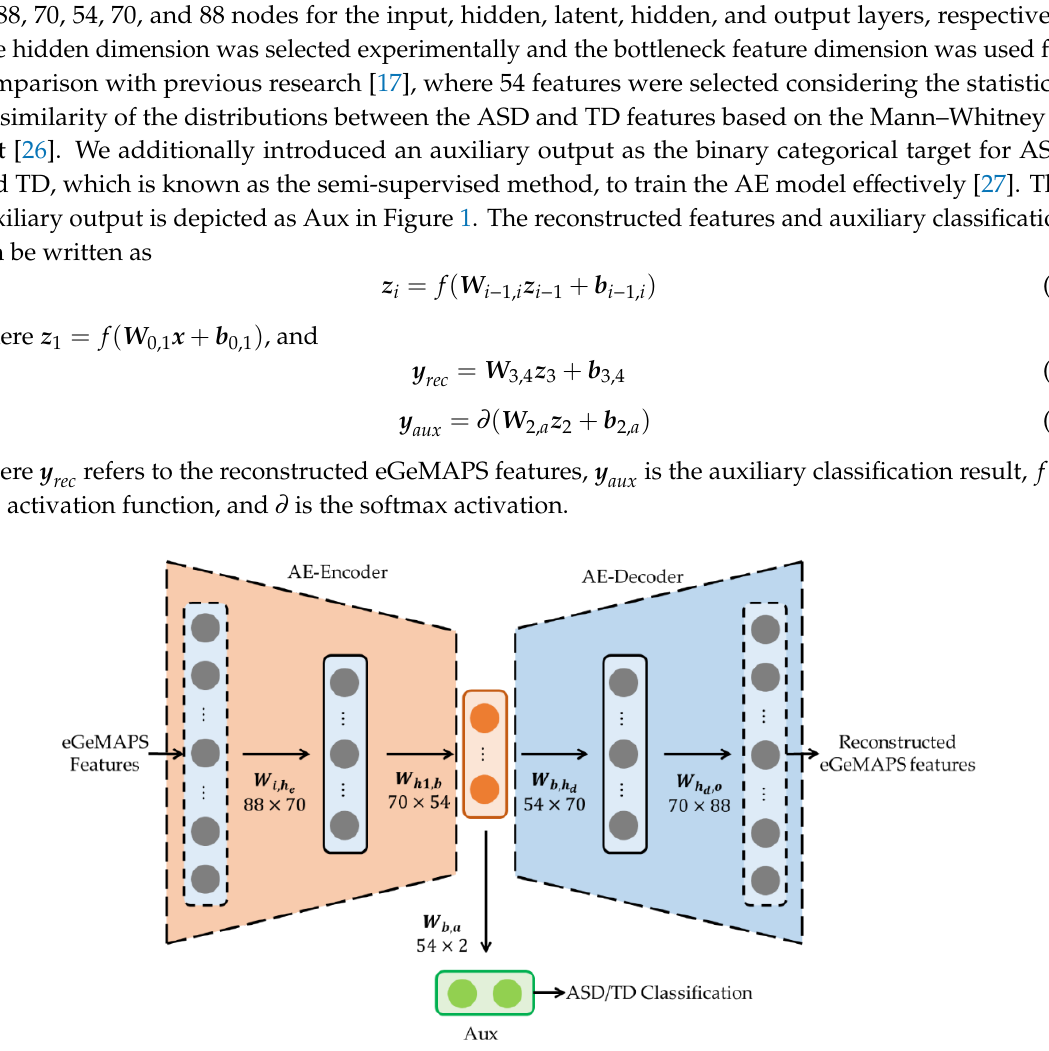
Figure 1. Structure of a semi-supervised auto-encoder (AE) model. eGeMAPS, extended version of the Geneva minimalistic acoustic parameter set; ASD, autism spectrum disorder; TD, typical development.